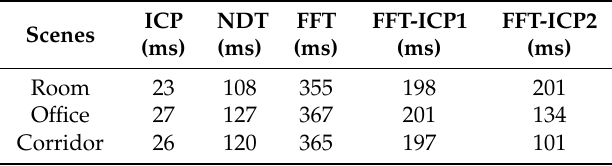
Table 4. Average run-time for different